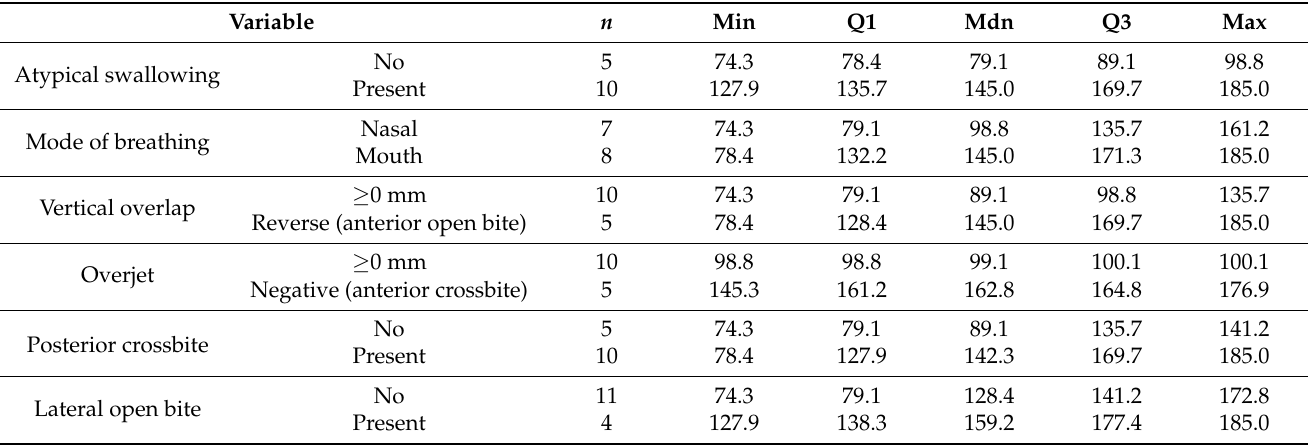
Table 4. Electrical activity of the superior orbicularis oris muscle [ µ V/ µ V%] during saliva swallowing in the DS group. Variable